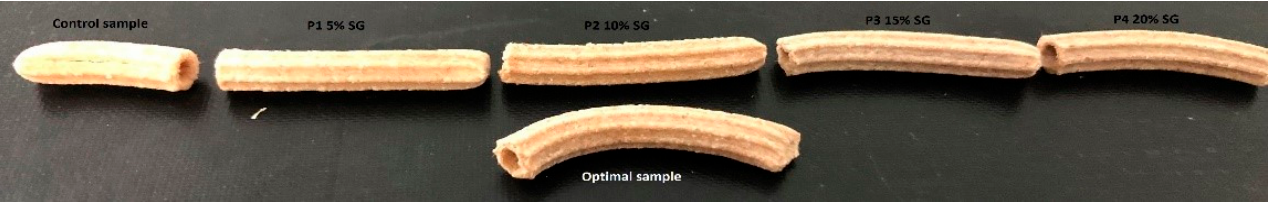
Figure 2. Pasta samples obtained in this research study.